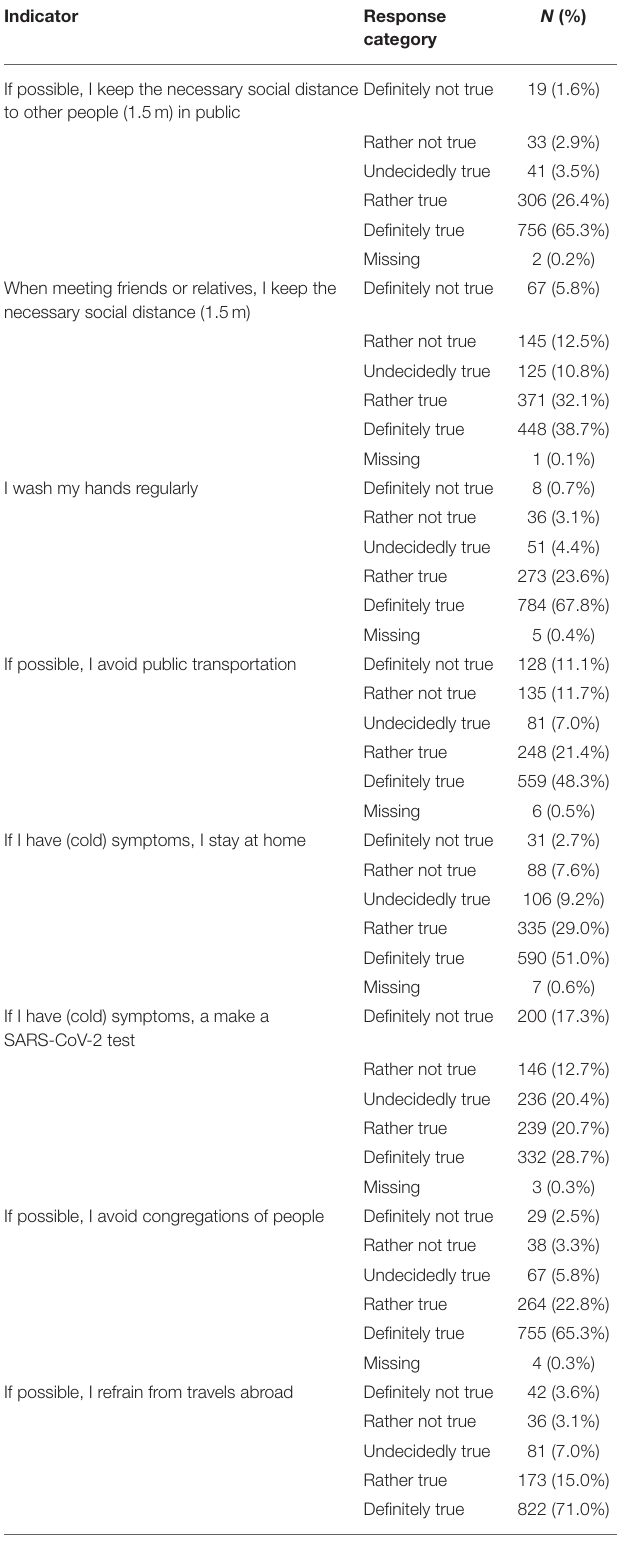
TABLE 1 | Non-compliance with non-pharmaceutical interventions to mitigate the spread of SARS-CoV-2 ( n = 1157).